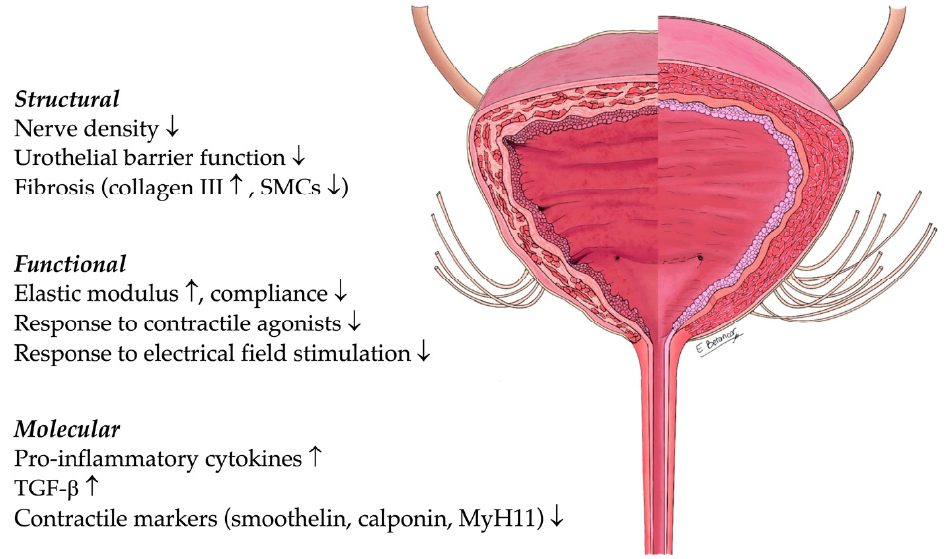
Figure 1. Structural, functional, and molecular changes in congenital NLUTD. The split image represents a healthy bladder on the right side and a NLUTD bladder on the left side. Abbreviations are as follows: NLUTD, neurogenic lower urinary tract dysfunction; SMCs, smooth muscle cells; TGF- β , transforming growth factor β ; MyH11, myosin heavy chain